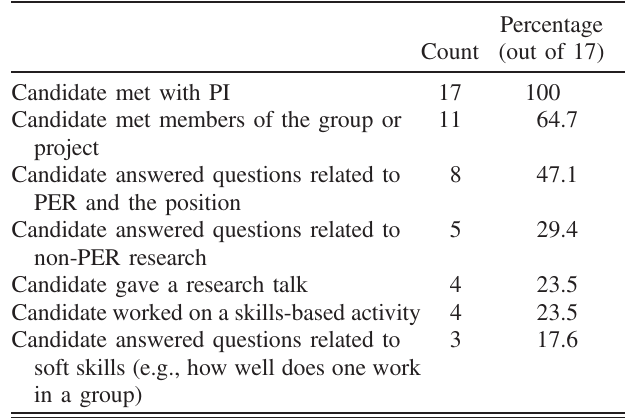
TABLE V. Summary of interview